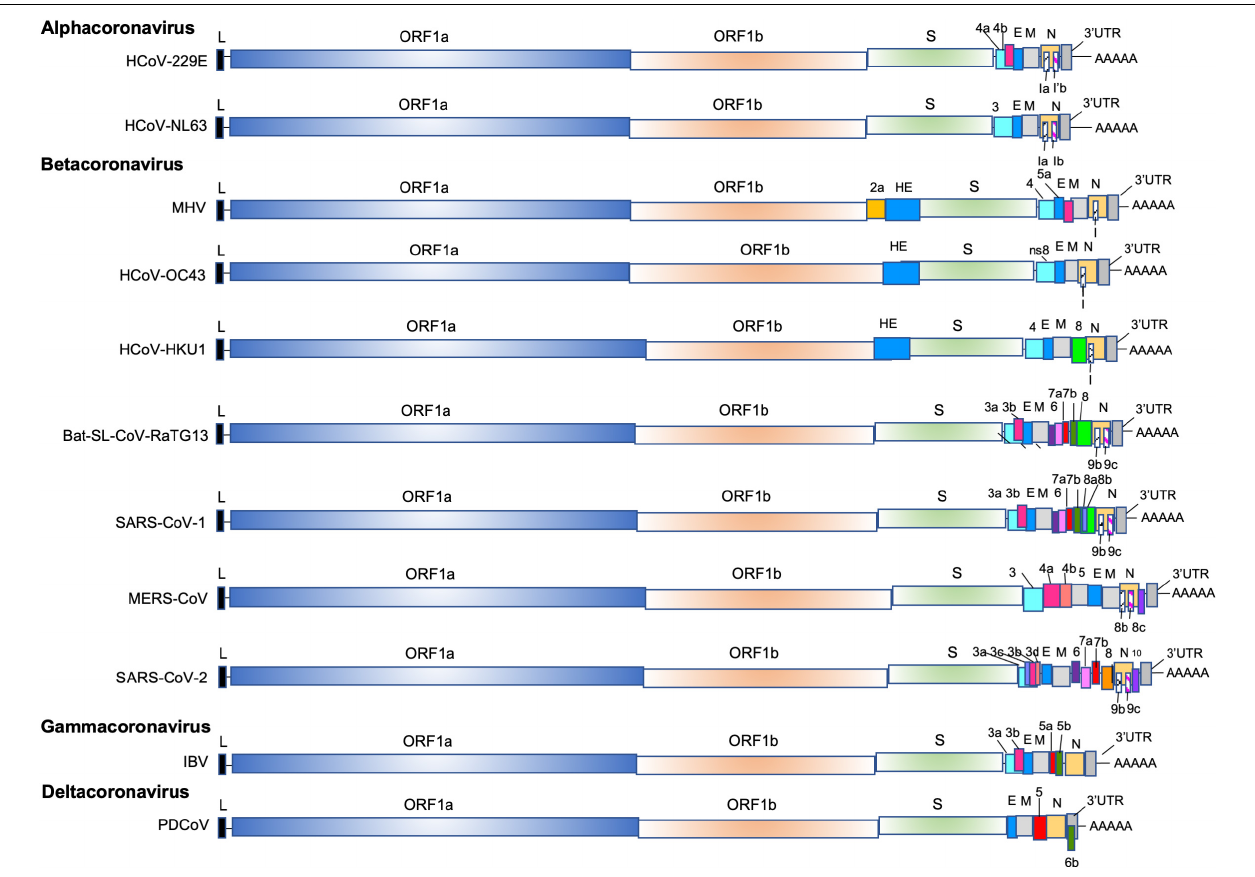
FIGURE 1 | The genomes of alpha-CoVs (HCoV-229E, HCoV-NL63), beta-Covs (MHV, HCoV-OC43, HCoV-HKU1, Bat-SL-RaTG13, SARS-CoV-1, MERS-CoV and SARS-CoV-2), delta-Covs (IBV), and gamma-CoVs (PDCoV). Coronaviruses contain a positive-sense, single-stranded RNA [ssRNA (+)] genome of 27–32 kb. The 5 (cid:48) -terminal two thirds of the genome encode a polyprotein pp1a and pp1b which are further cleaved into 16 nps that are involved in genome transcription and replication. The 3 (cid:48) terminus encodes structural proteins: envelope glycoprotein (S), envelope (E), membrane (M), and nucleocapsid (N). In addition, accessory genes species-specific are interspersed or embedded as an alternative ORF within another genes (the ORF I gene of MHV, the Ia and Ib gene). The SARS-CoV-1 (SARS-CoV-1 reference sequence AY274119) possess 9 ORFs (ORF3a, 3b, 6, 7a, 7b, 8a, 8b, 9b, and 9c), the MERS (MERS-CoV reference sequence NC_019843) retains 6 ORFS (ORF3, 4a, 4b, 5, 8b, and 8c), and the SARS-CoV-2 (SARS-CoV-2 reference sequence NC_045512) has 11 ORFS (ORF3a, 3b, 3c, 3d, 6, 7a, 7b, 8, 9b, 9c, and